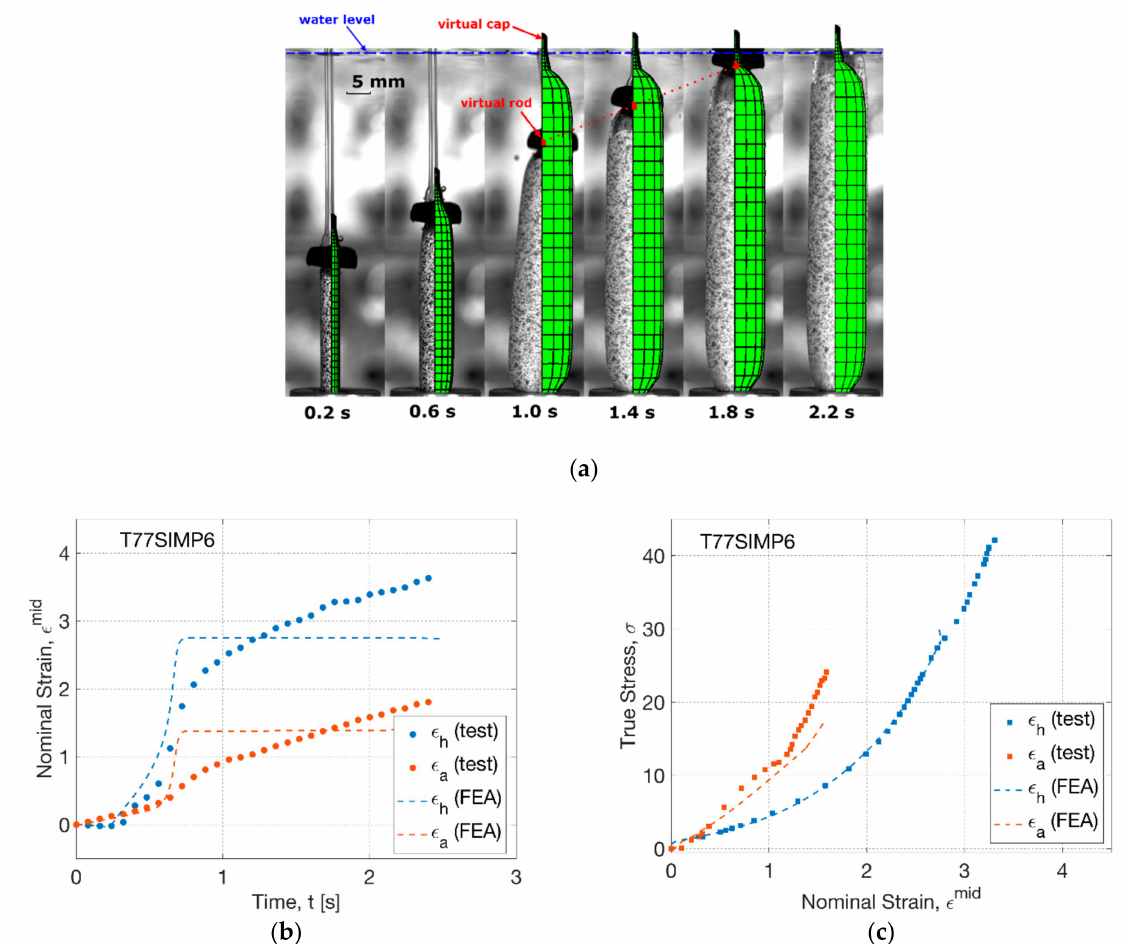
Figure 11. Comparison of results from FEA simulation and blowing test (T77SIMP6): ( a ) shape evolution, ( b ) strain history, ( c ) stress–strain